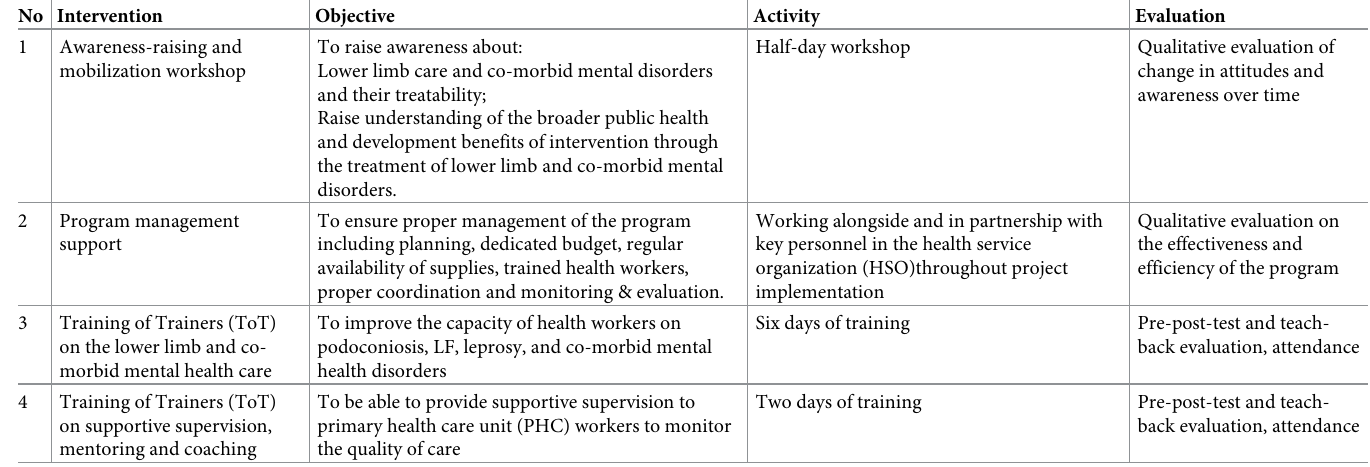
Table 1. Health Organization (HSO) level